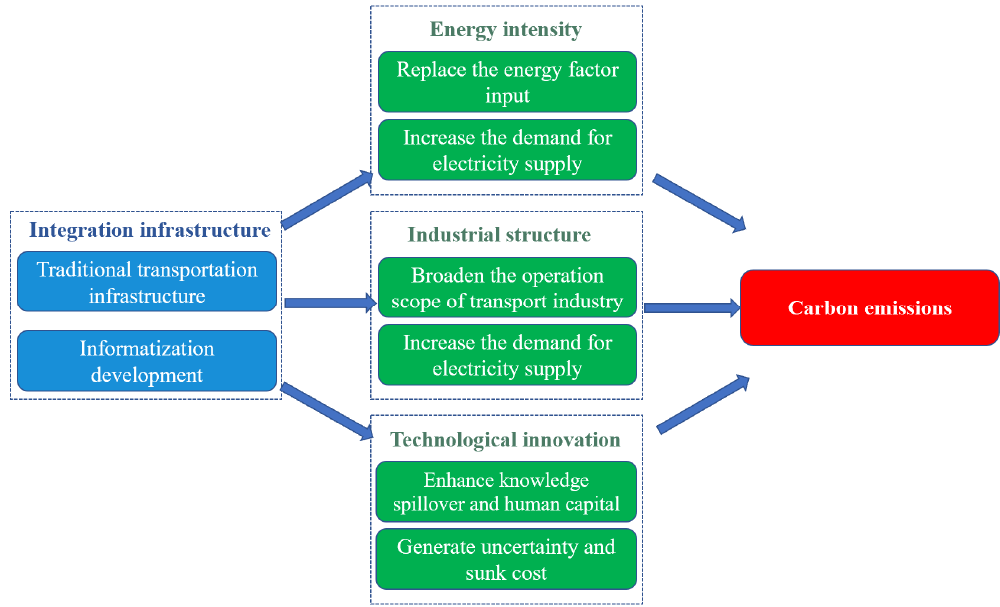
Figure 1. The impact mechanism.